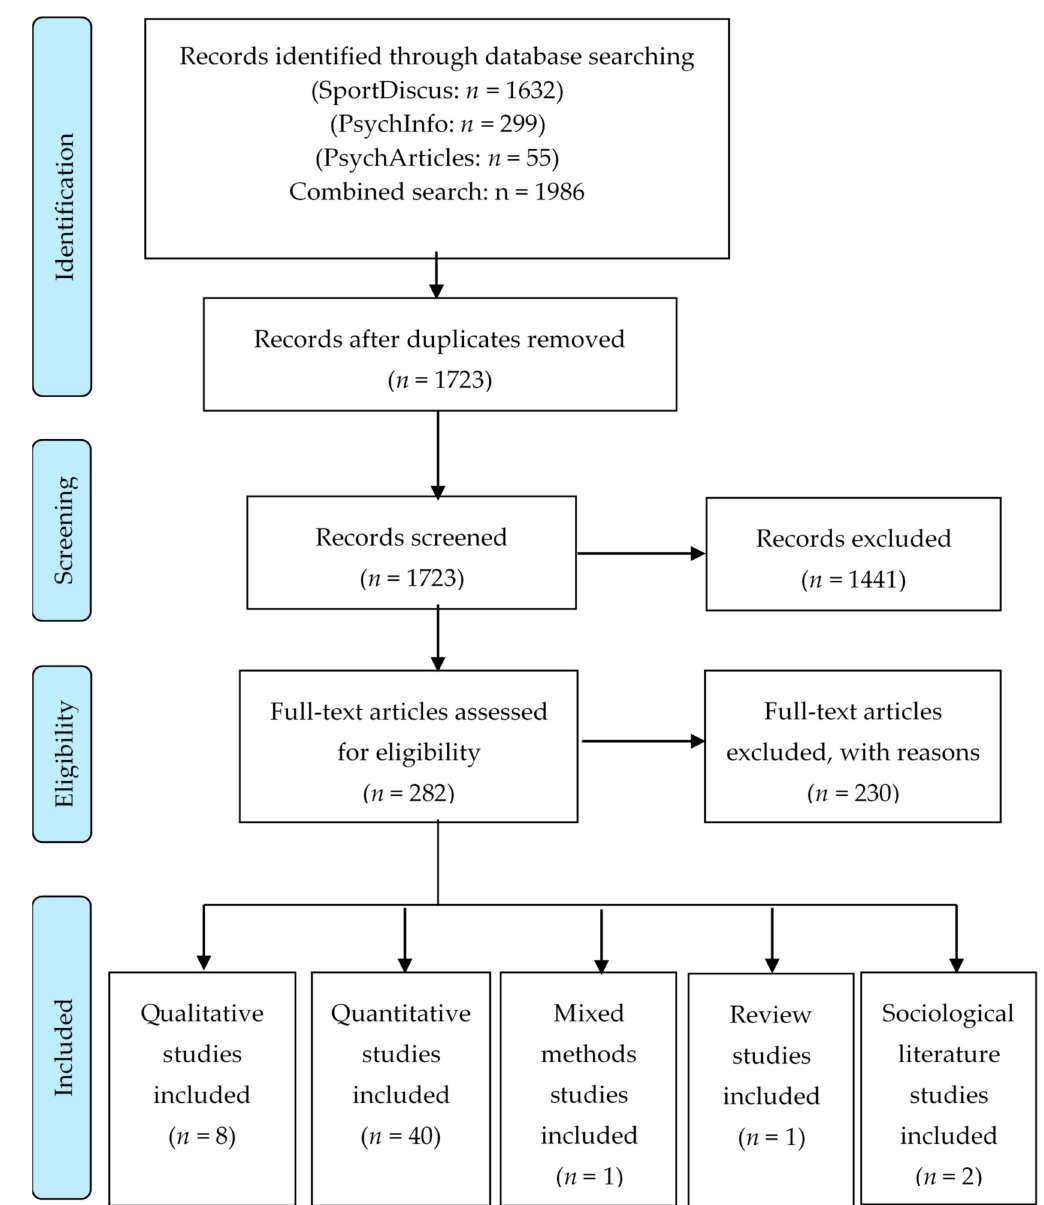
Figure 1. PRISMA flow